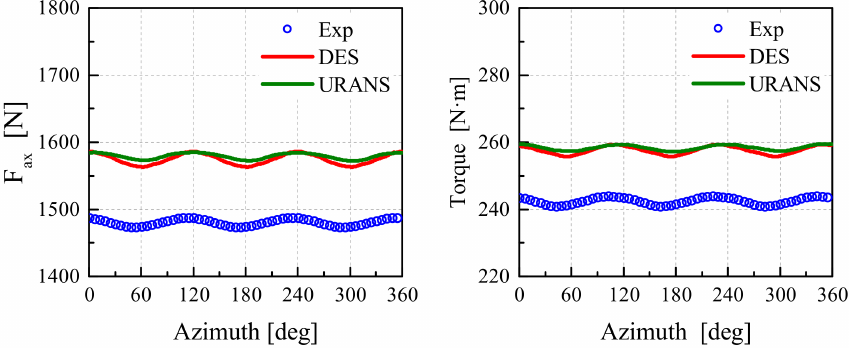
Figure 4. Comparison of the rotor axial force and torque at the wind speed of 15 m/s, TSR =